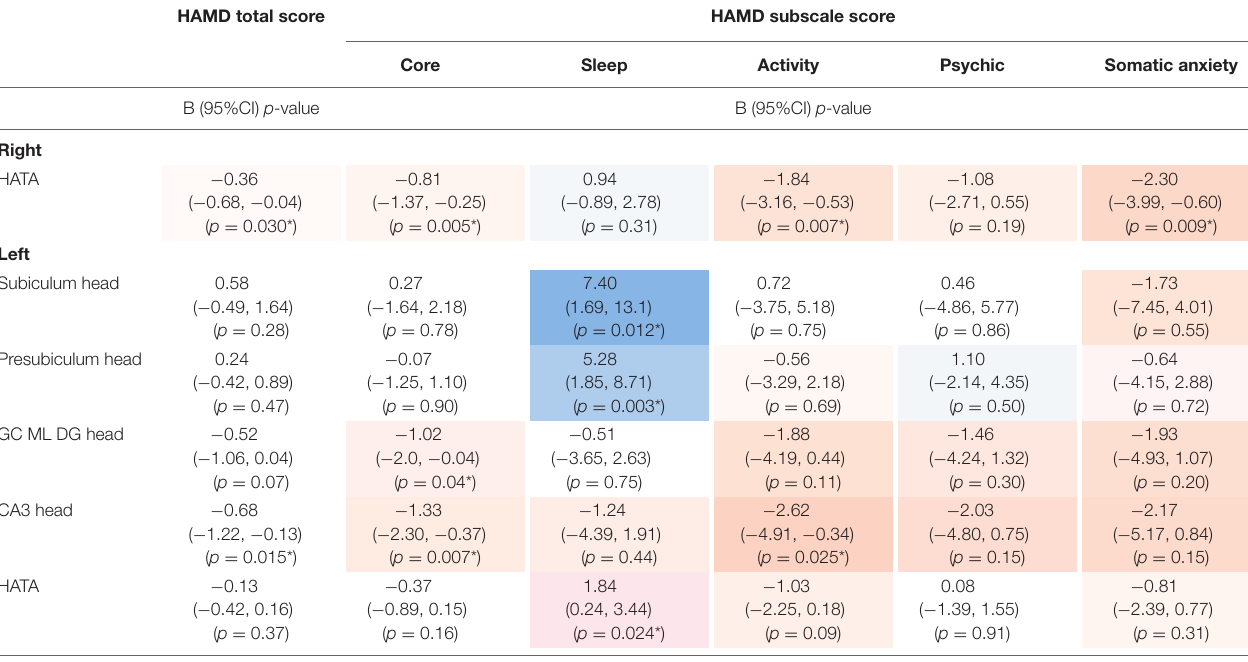
TABLE 5B | The HAMD scores and hippocampus subfields (Heat Map). HAMD total score HAMD subscale score Sleep Activity Psychic Somatic